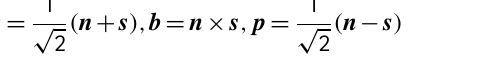
Figure 2. The hypocenter distribution of selected events. Fig. 2. The hypocenter distribution of selected events.